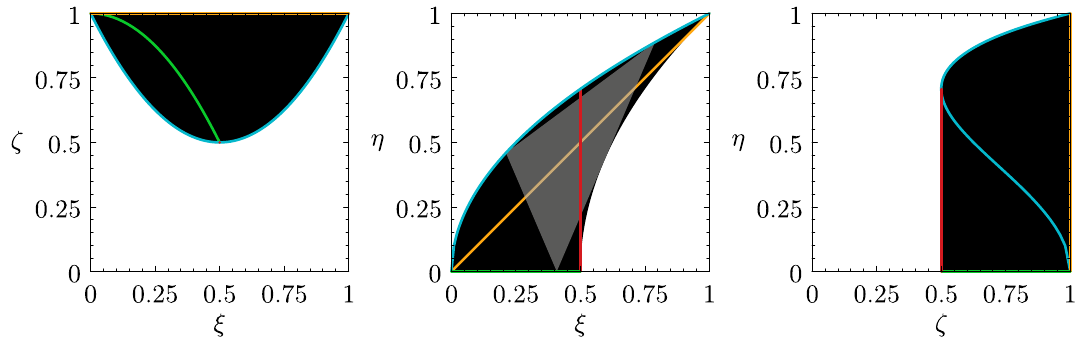
Fig. 1 Two-dimensional projections of the orbit space on the ξζ -, ξη - The projection on the ξη -plane is the union of such slices. The vertex A that yields physical EWSB is projected to the upper-right corner of and ζη -planes, respectively. Boundary solutions I, II, III, and IV are each shown in blue, green, yellow and red, respectively. The middle panel triangular slice of the orbit space in gray. also shows the constant ζ = 2 3